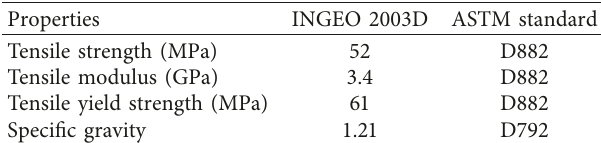
Table 5: Properties of PLA [59].